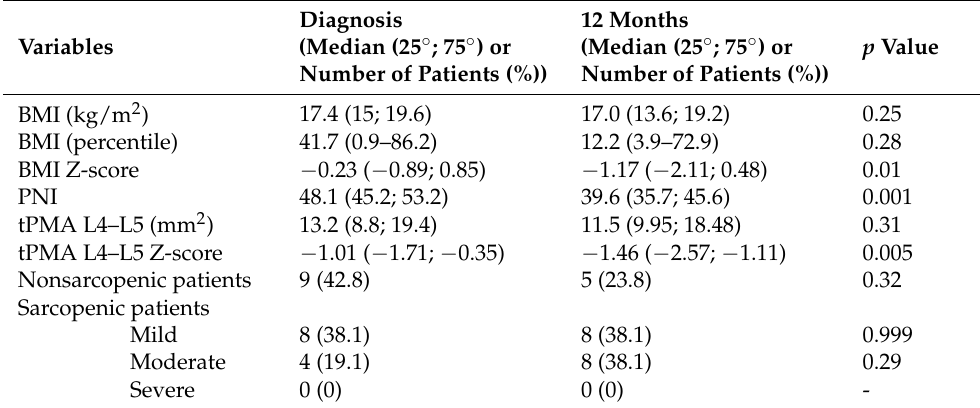
Table 2. Comparison of nutritional status variables and sarcopenia status rates at diagnosis and after 12 months of treatment.